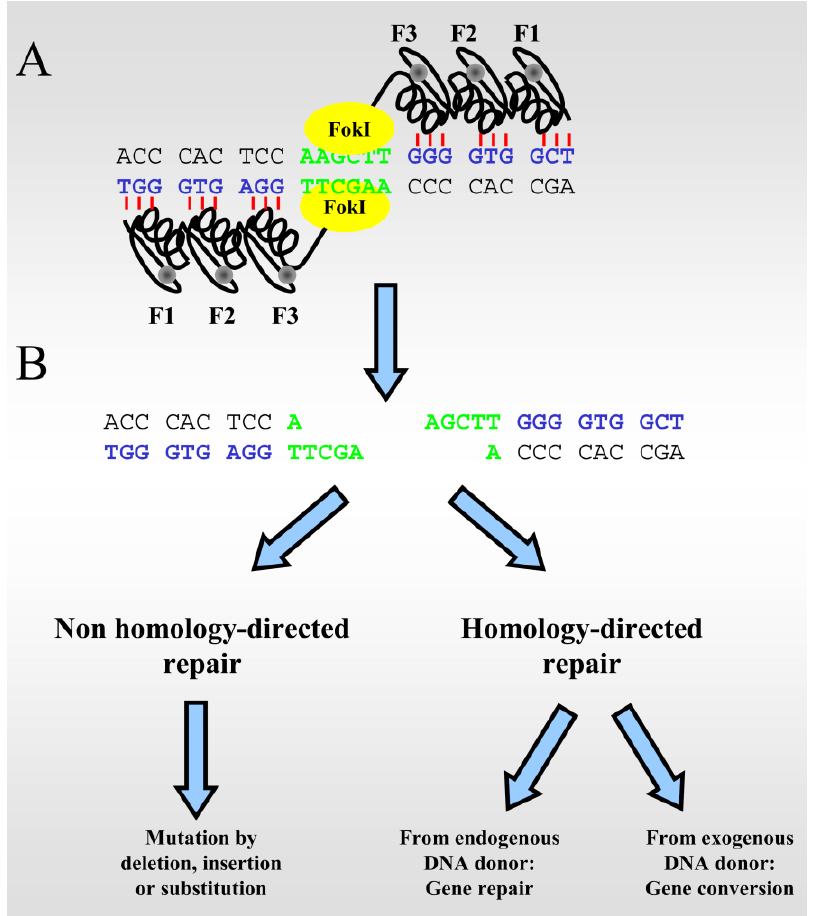
FIGURE 3. Mutagenesis induced by zinc-finger nuclease activity. (A) Cartoon of the structure of the zinc-finger nuclease dimer described by Morton et al.[56] containing three fingers (F1, F2, and F3). Black lines represent the amino acid sequence of the peptide. Grey dots represent zinc ions. Red bars represent the binding of each finger to the triplet motif specifically recognised by the finger. The Fok I nuclease domain is labelled yellow. (B) Digestion of the target by the zinc-finger nuclease induces DSB. This lesion can be repaired by end-joining ligation, which may induce mutagenesis of the locus . Otherwise the lesion can be resected by nucleases and hence the gap will be repaired by copying the sequence from a homologous sequence resulting in gene repair or gene conversion (see legend to Fig.